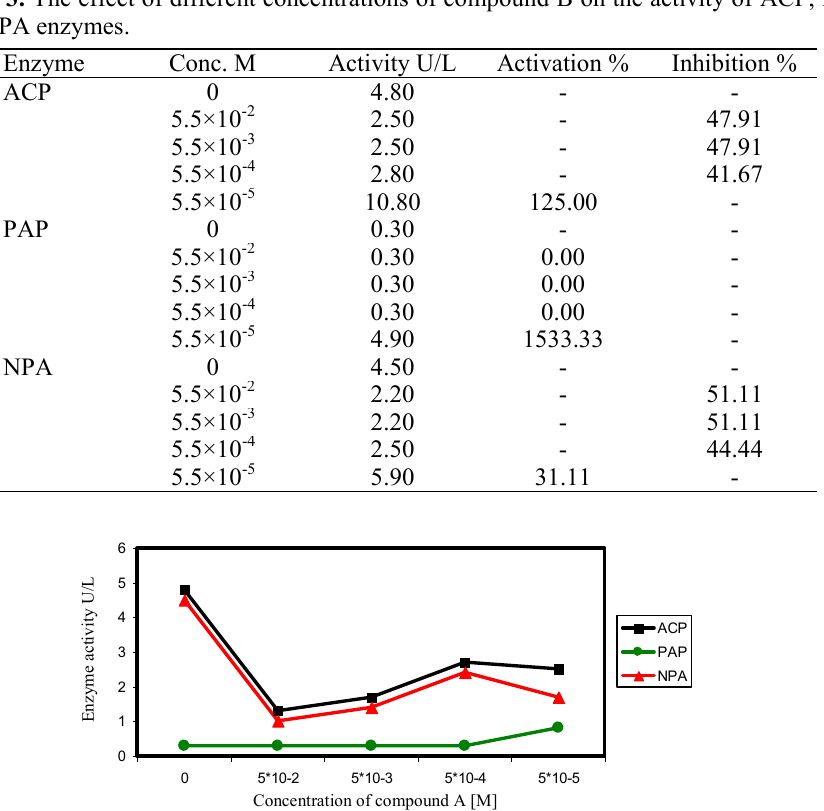
Figure 3. The levels of ACP, PAP and NPA enzymes in the presence of different concentrations of compound